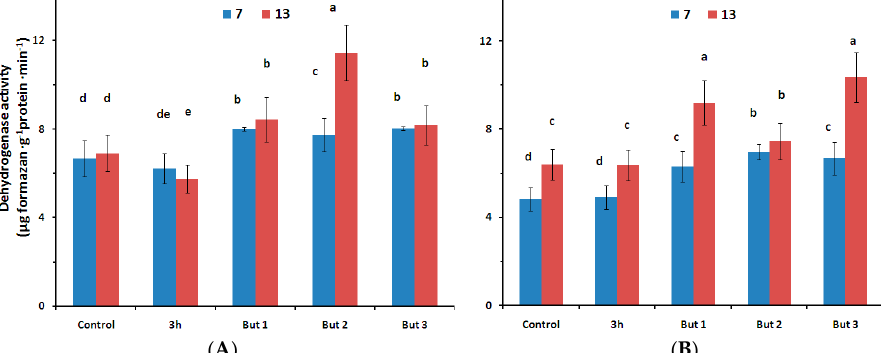
Figure 3. Dehydrogenase activity (DA) [ μ g formazan·g − 1 protein·min − 1 ] in the seeds of two L. angustifolius Lazur cultivars (Lazur—( A ); and Sethes Fruehe Rote—( B )) germinating at 7 °C or 13 °C in water (control), butenolide or hydroprimed in water for 3 h at 20 °C. But 1, But 2, But 3: 10 − 6 M, 10 − 5 M, 10 − 4 M butenolide, respectively. Different letters over error bars (±SE; n = 5) indicate significant differences (Duncan’s multiple range test, p < 0.05).